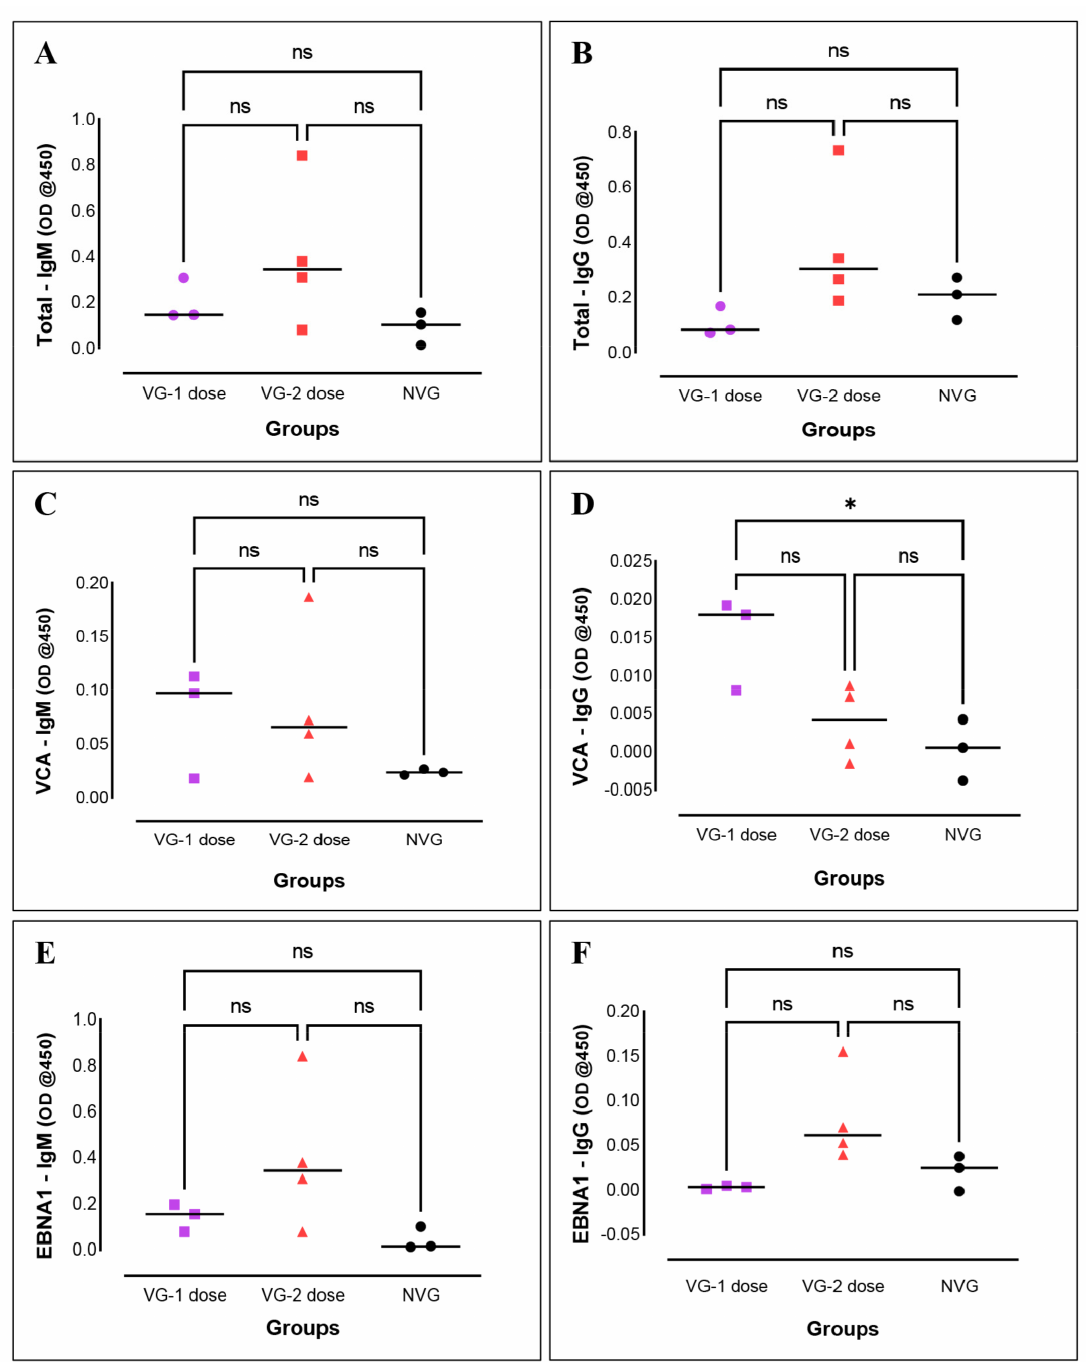
Figure 1. Antibody response in rabbits to EBV proteins. IgM and IgG immune response against total EBV proteins in rabbits immunized with VIG 1-dose, VIG 2-dose, and NVIG ( A , B ) and EBV specific IgM and IgG immune responses against VCA ( C , D ) and EBNA1 ( E , F ). All the data were normalized with the NVNIG controls and plotted against their respective ODs. Antibody titers are presented with mean ± SEM, and comparisons were made using paired t -tests. ns: p > 0.05, * p ≤